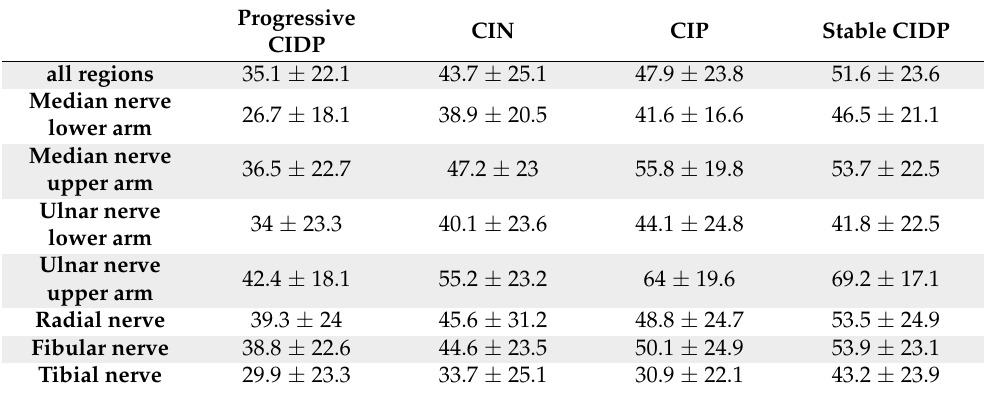
Table 2. Mean fraction of black of all groups.